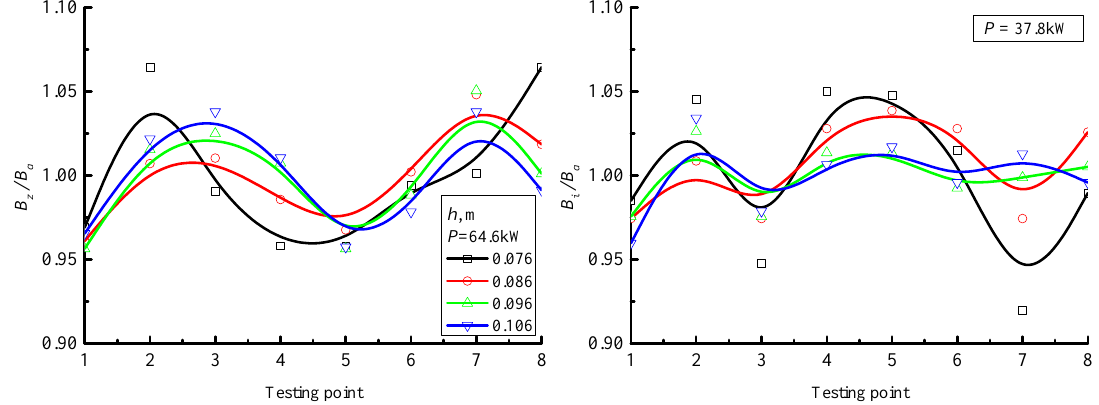
Figure 5. Magnetic flux density distribution at different level of h for different testing locations for P = 64.6 kW ( left ) and 37.8 kW ( right